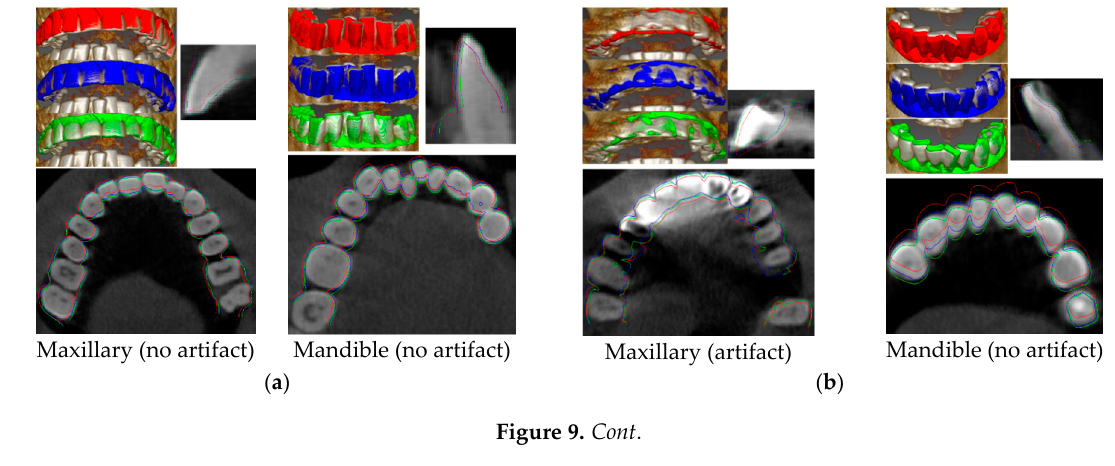
Table 4. MICP registration results using uniform down sampled data.